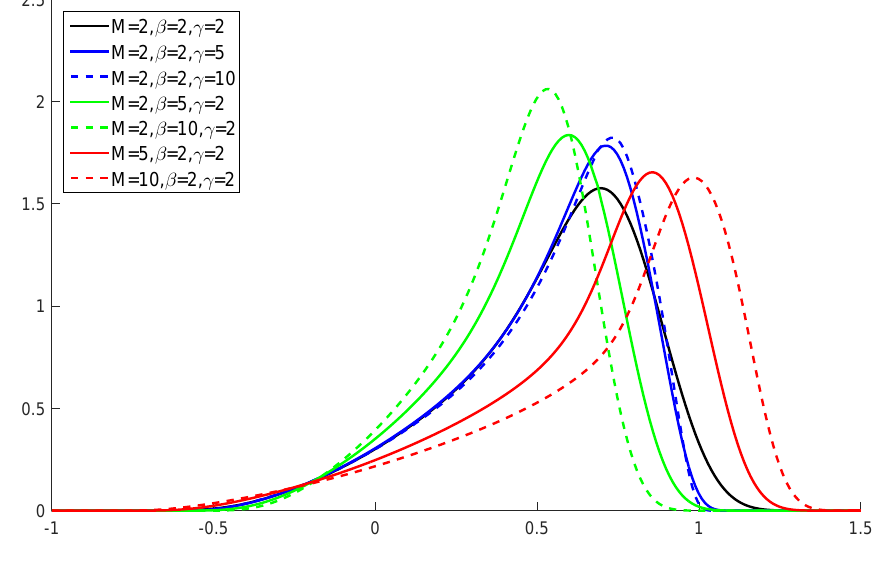
Figure 1: Maximum pdf from l 4,3 -symmetric sample vector distribution, f 4:4 , if the dg is g (4)